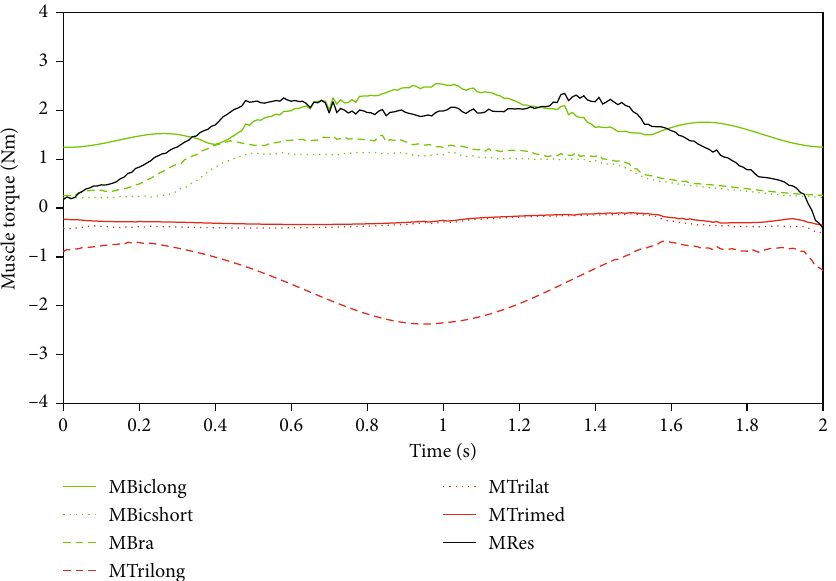
Figure 12: Elbow torque distributed among the muscles calculated according to the model in this